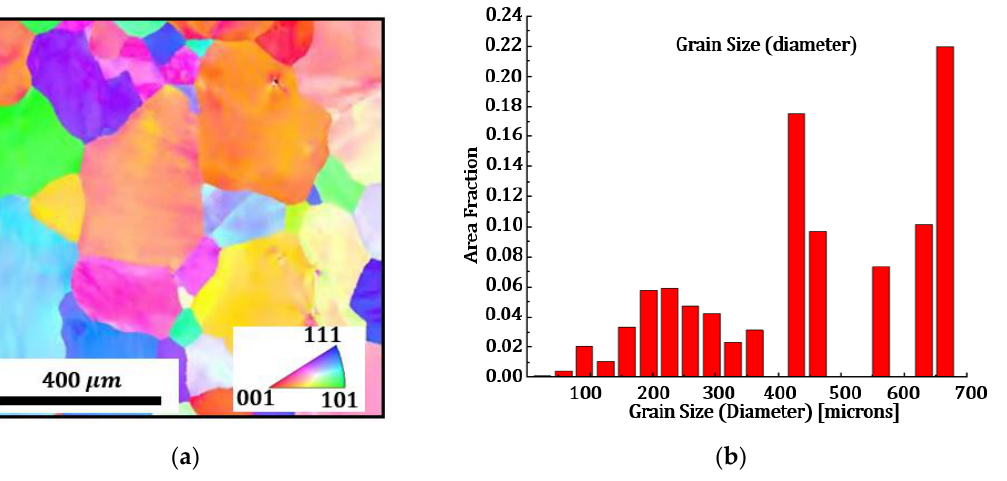
Figure 1. Initial microstructure of the as-received CoCrFeMnNi rod blank: ( a ) grain microstructure; ( b ) grain size.